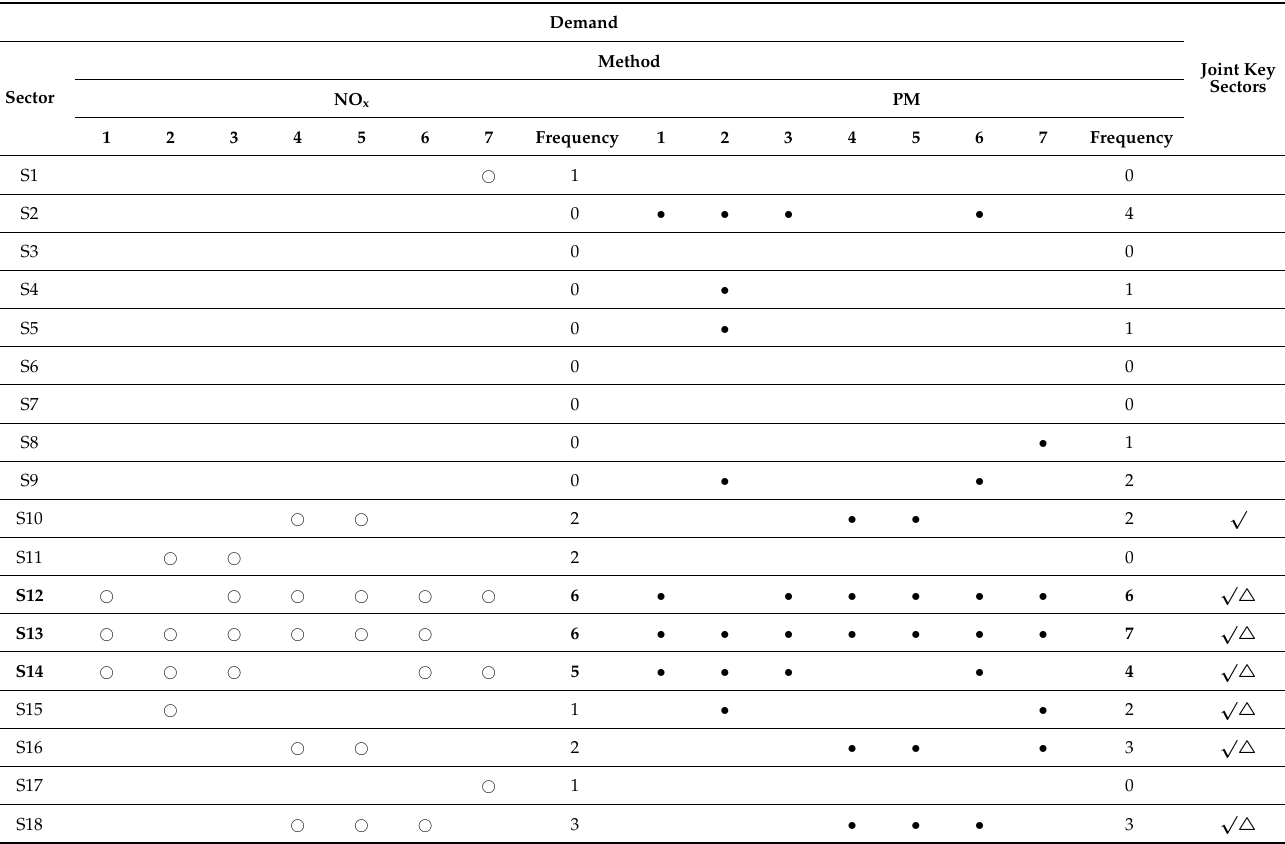
Table 11. The key demand-side sectors of NO x and PM emissions.